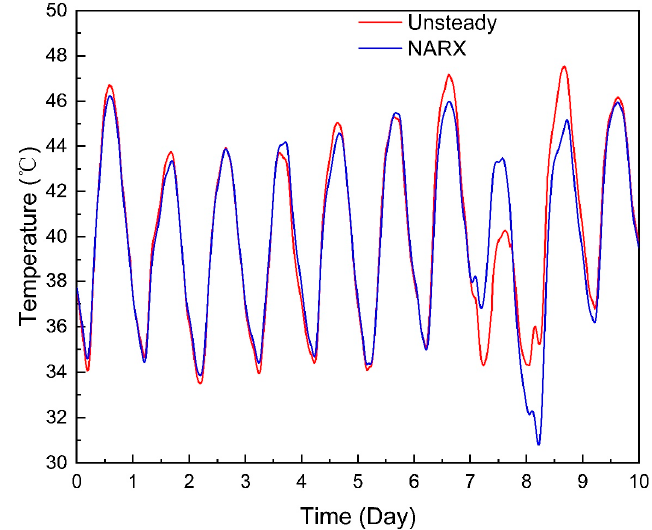
Figure 9. NARX neural network